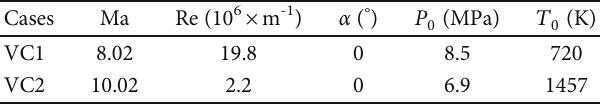
Table 2: Experimental conditions of the two validation